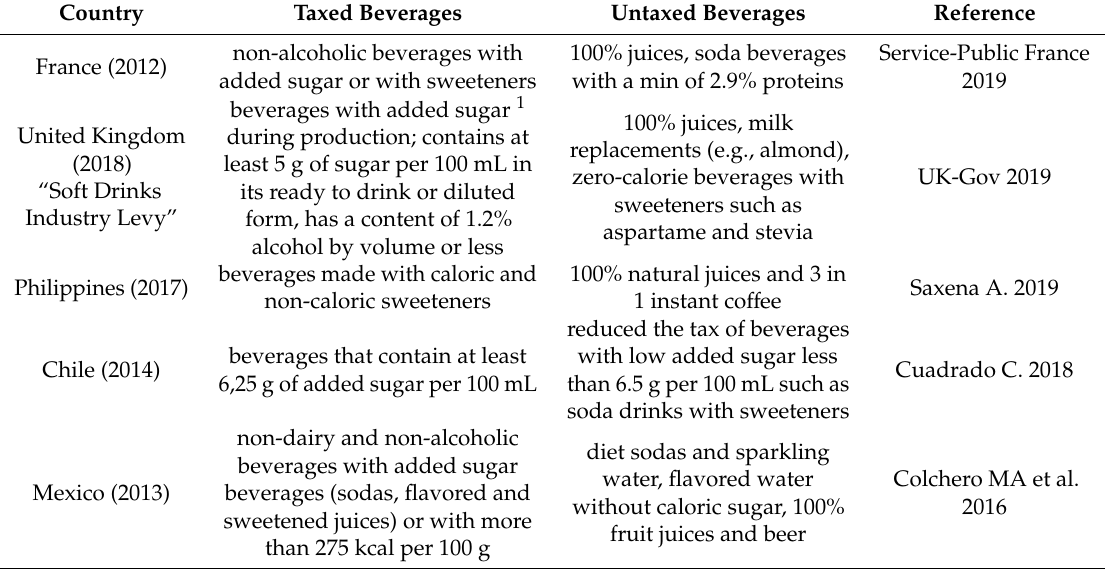
Table A1. Example of countries with taxed and untaxed sweet beverages (selection of countries) 2